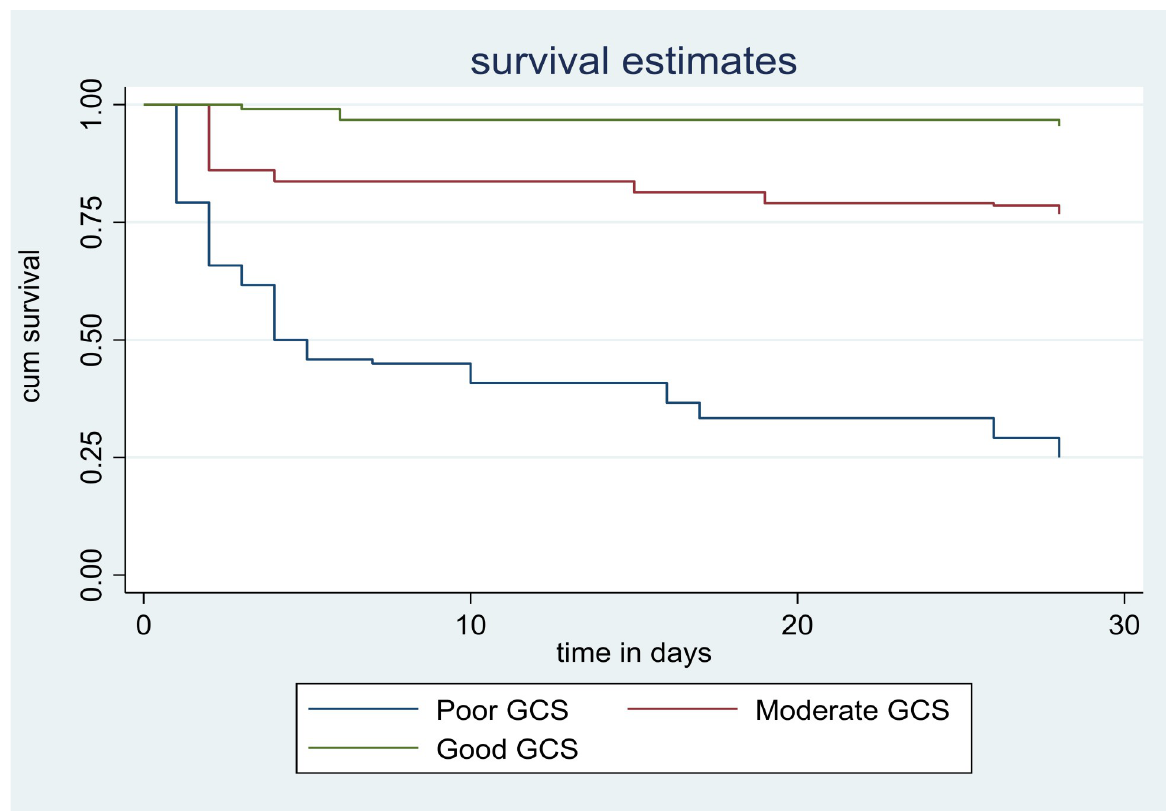
Fig 3. Survival probability curves derived from Log rank Kaplan Meier of fatality after 28 day follow up and GCS score.